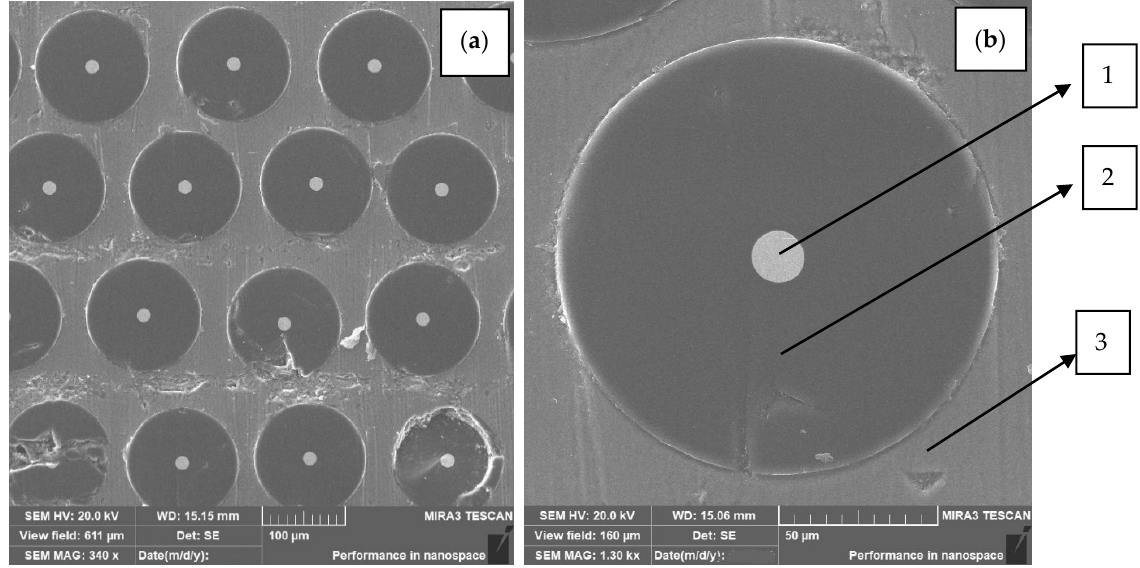
Figure 3. Al-W-B microstructure ( a , b ): 1—tungsten wire rod 10–12 µm, 2—boron coating with a diameter of 70–100 µm; 3—matrix material aluminium.